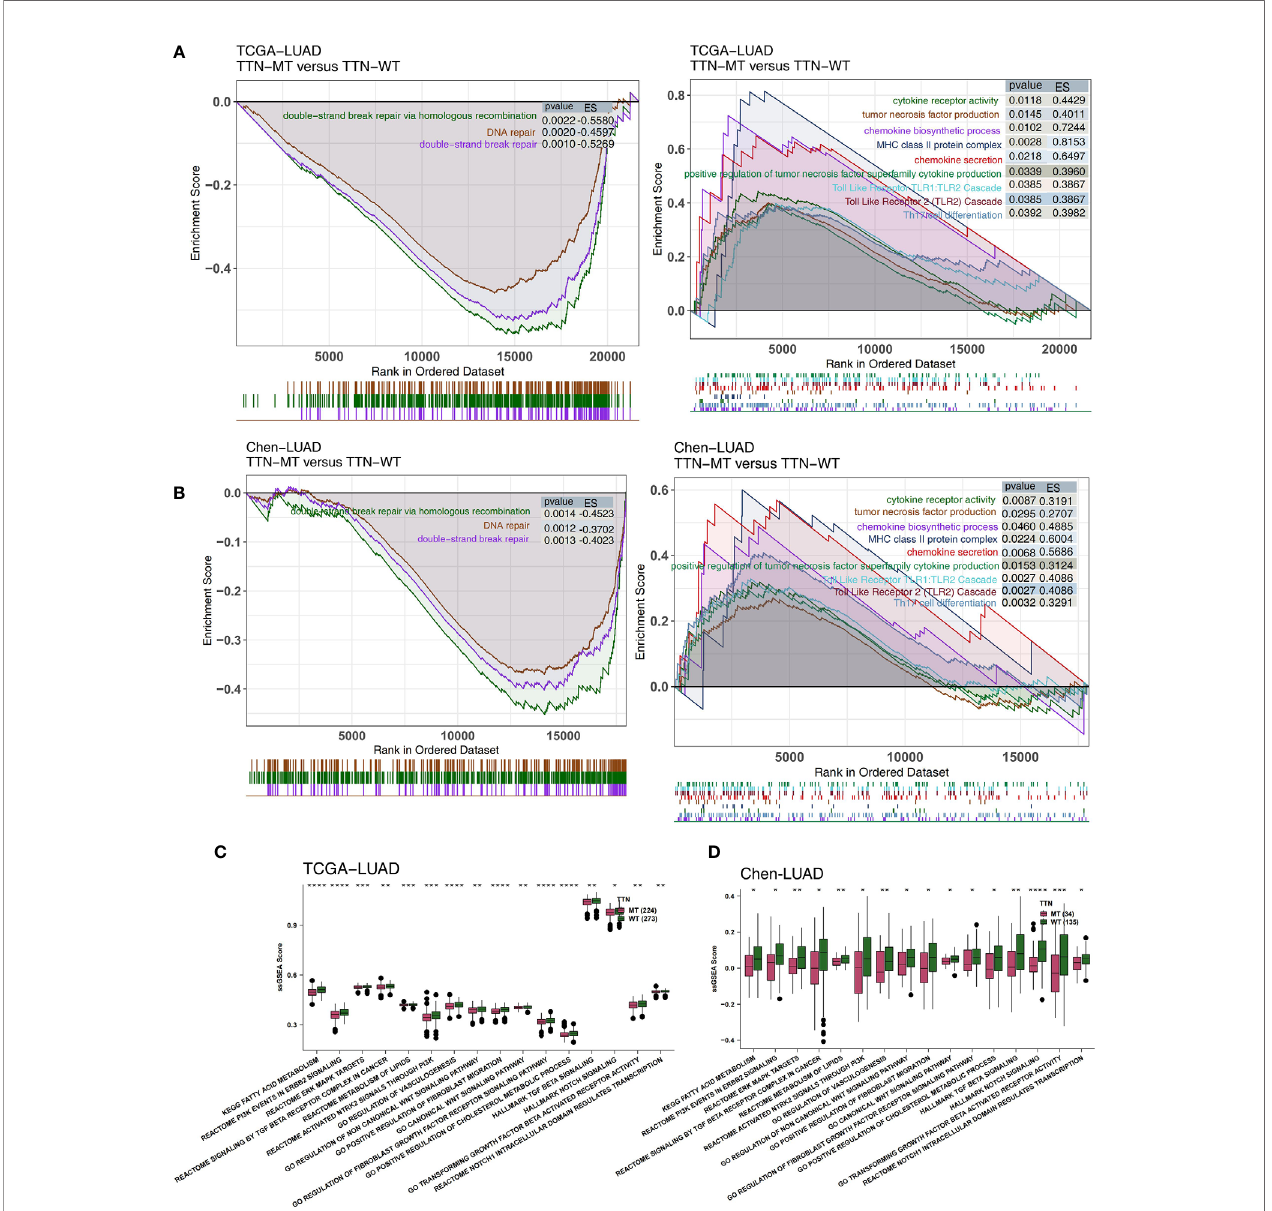
FIGURE 5 | Association of TTN status and the activity of signaling pathways in the LUAD patients. The results of GSEA in the TCGA-LUAD (A) and the Chen-LUAD cohort (B) . The color of the curve corresponds to the font color of the pathway. The GSEA of hallmark gene sets was downloaded from the MSigDB, and each run was performed with 1,000 permutations. Enrichment results with signi fi cant differences between TTN-MT and TTN-WT tumors are shown. Heatmap depicting the mean differences in ssGSEA score between TTN-MT and TTN-WT in the TCGA-LUAD (C) and the Chen-LUAD cohort (D) . The y-axis indicates the ssGSEA score of pathways. Each square represents the fold change or difference of each indicated ssGSEA score of pathways between TTN-MT and TTN-WT tumors in LUAD. Red indicates upregulation, while blue indicates downregulation. *P < 0.05; **P < 0.01; ***P < 0.001; ****P <